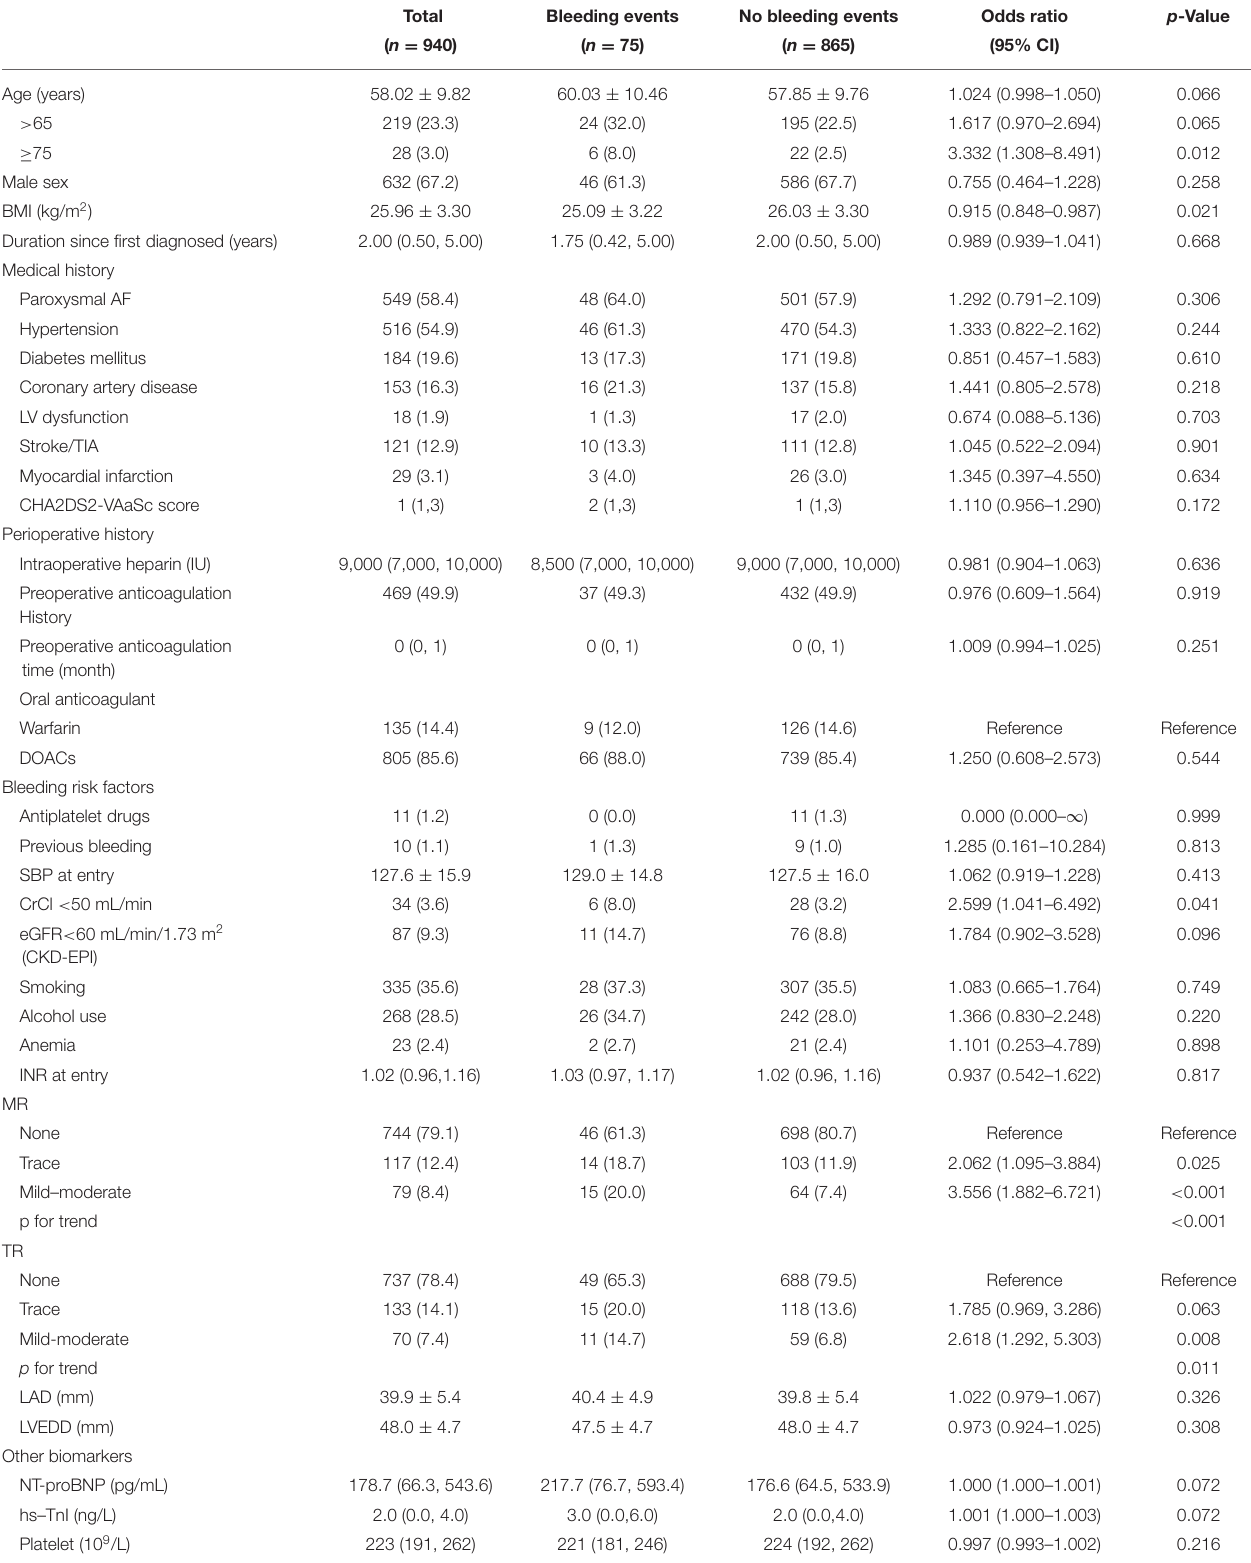
TABLE 1 | Baseline characteristics of patients with AF regarding bleeding. Total Bleeding